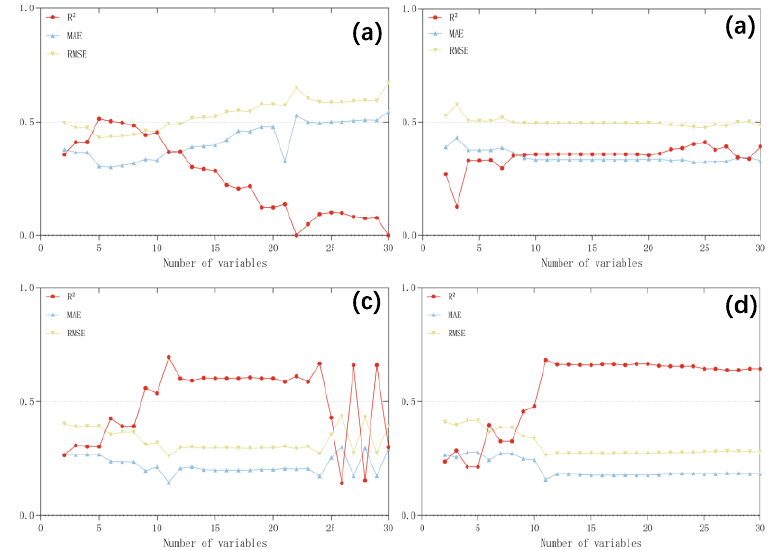
Figure 4. Model performance of different sets of environmental variables after SVM-RFE feature selection. ( a ) MLR: multiple linear regressions; ( b ) RF: random forest; ( c ) GBDT: gradient boosting decision tree; ( d ) XGBoost: extreme gradient boosting.